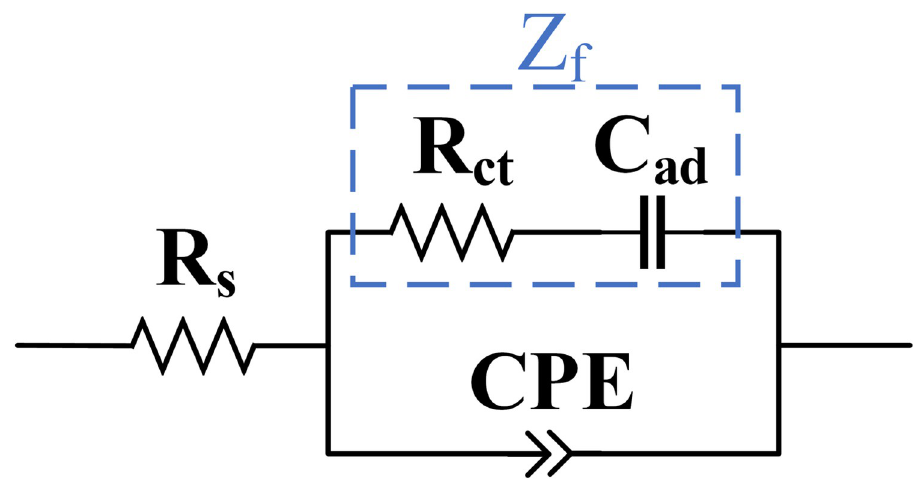
Fig 9. Modified Randles equivalent circuit model of microelectrodes for electrochemical impedance modelling. The equivalent circuit comprises a series resistor (R s ), charge transfer resistor (R ct ), adsorption capacitor (C ad ), and constant phase element (CPE). Z f represents the Faradaic impedance of the circuit as a series combination of R ct and C ad